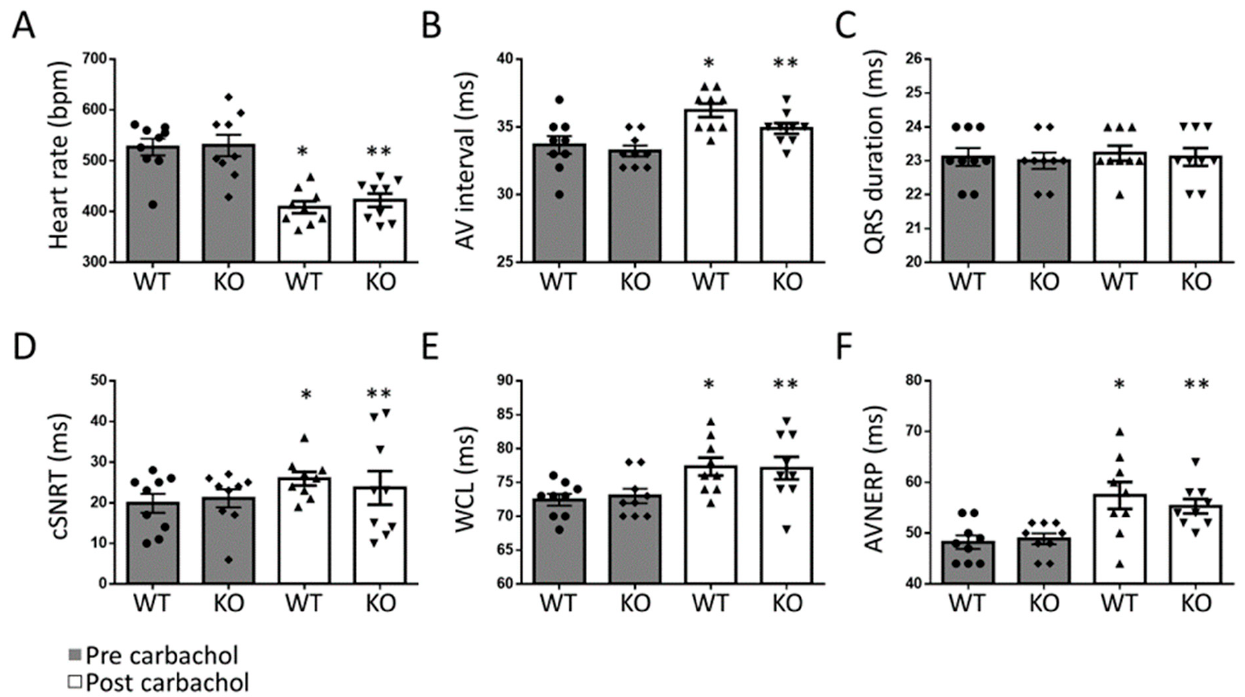
Figure 1. Electrophysiological properties in G q -KO (n = 11) and control mice (n = 10) before and after vagal stimulation with carbachol. Heart rate ( A ), atrioventricular (AV) interval ( B ), QRS duration ( C ), corrected sinus node recovery time (cSNRT, D ), Wenckebach cycle length (WCL, E ), and effective refractory period of the AV-node (AVNERP, F ). * p < 0.05 vs. WT pre carbachol. ** p < 0.05 vs. KO pre carbachol.